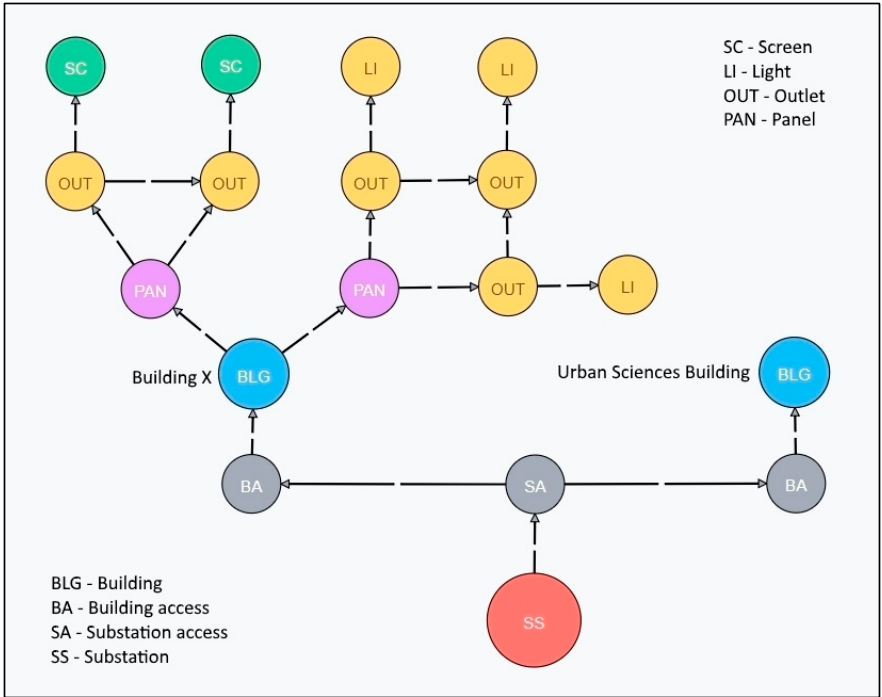
Figure 6. The integrated topology of the electricity distribution network highlighted in Figure 2 and the internal electrical components of Building X, as shown in Figure 3.